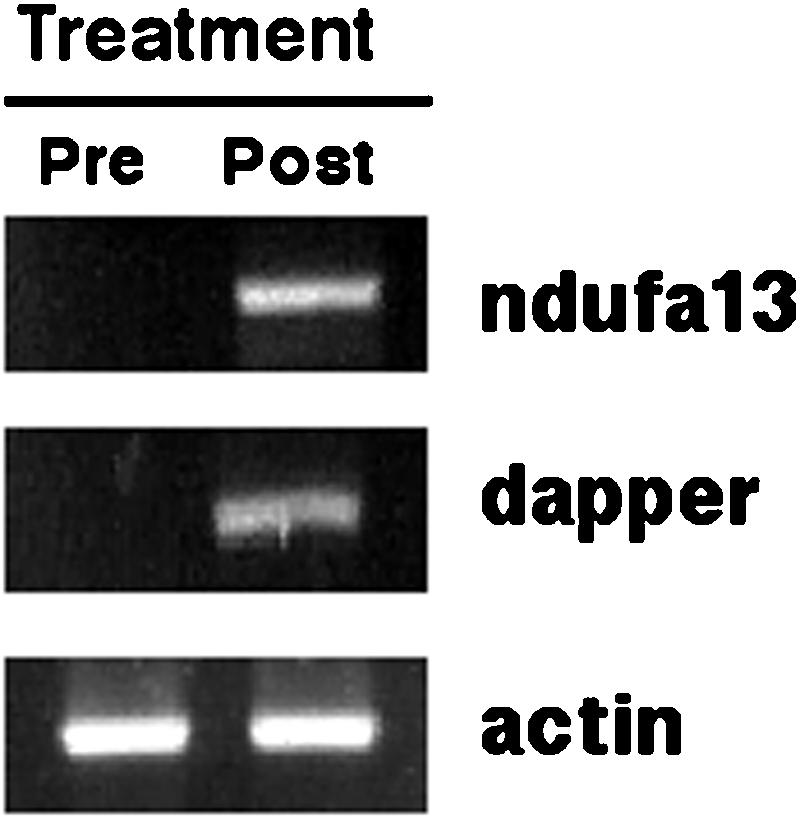
Gene expression by RT-PCR. RT-PCR of NDUFA13 and DAPPER genes in biopsies from the primary tumor showing that these genes were reactivated after treatment. This corresponds to one of the three patients whose biopsy (only post-treatment) was analyzed by microarray and showed over-expression of these genes.